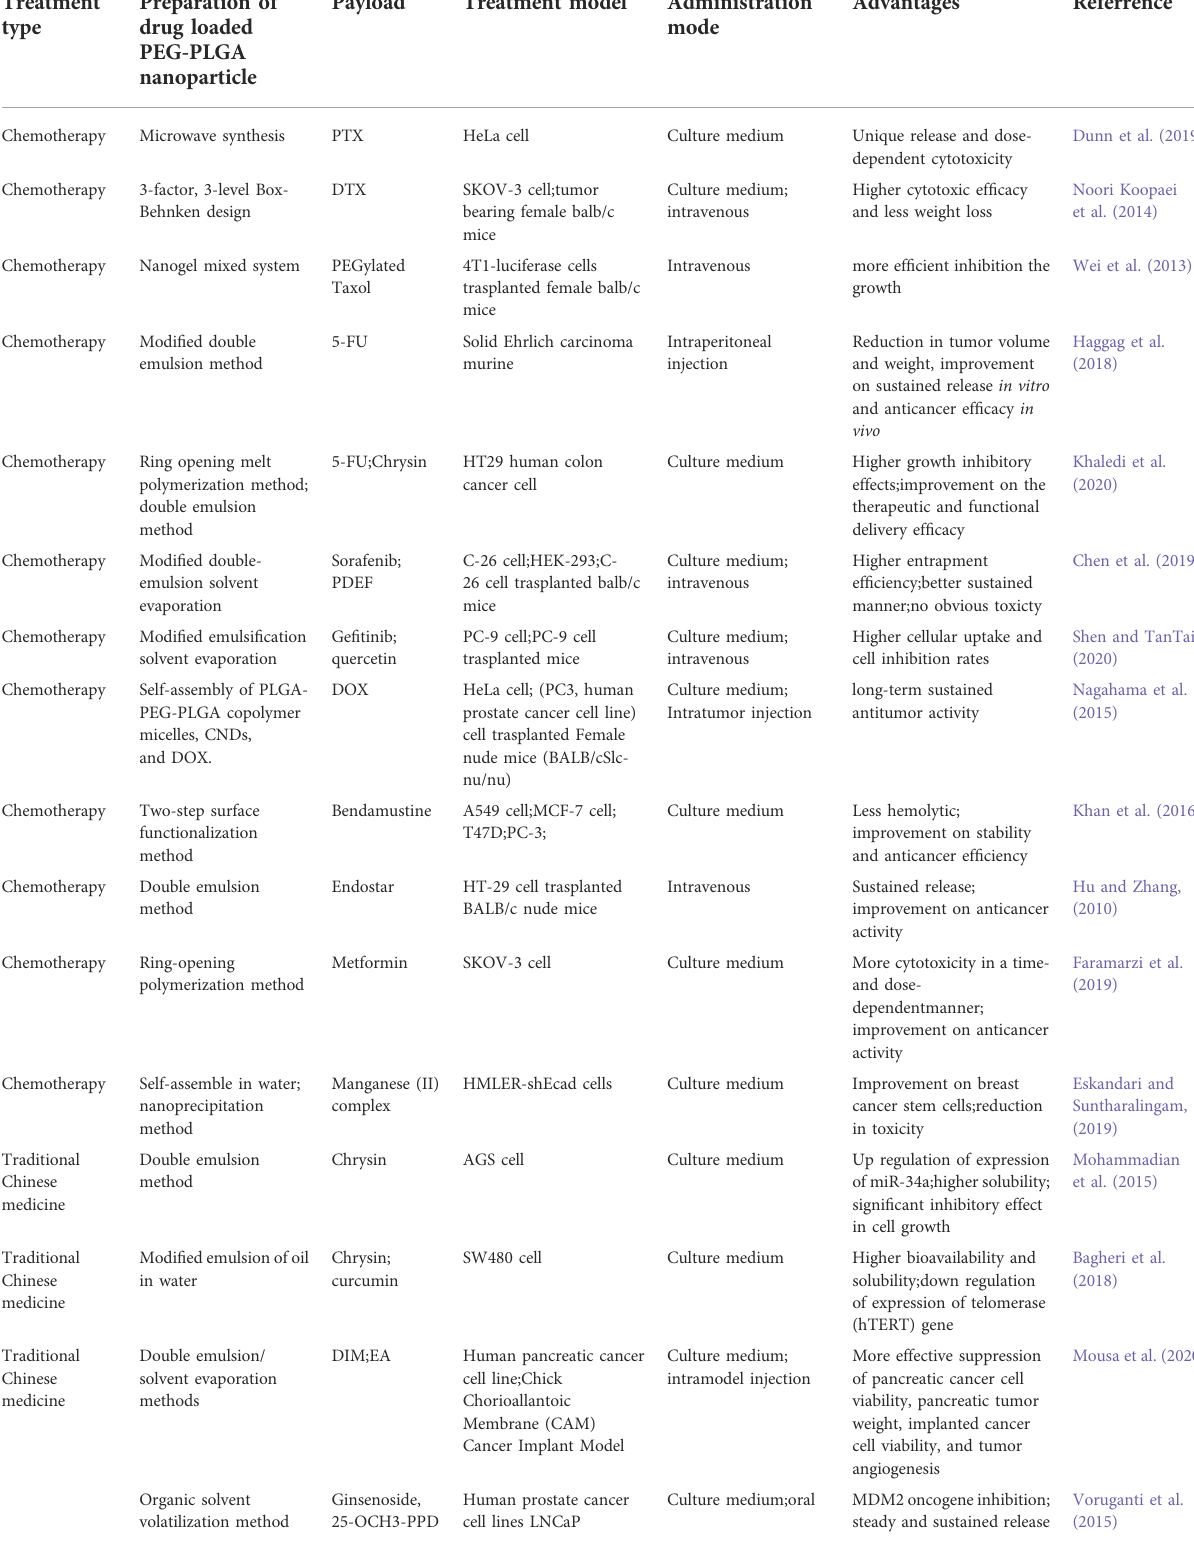
TABLE 1 Recent applications of PEG-PLGA nanoparticles as drug